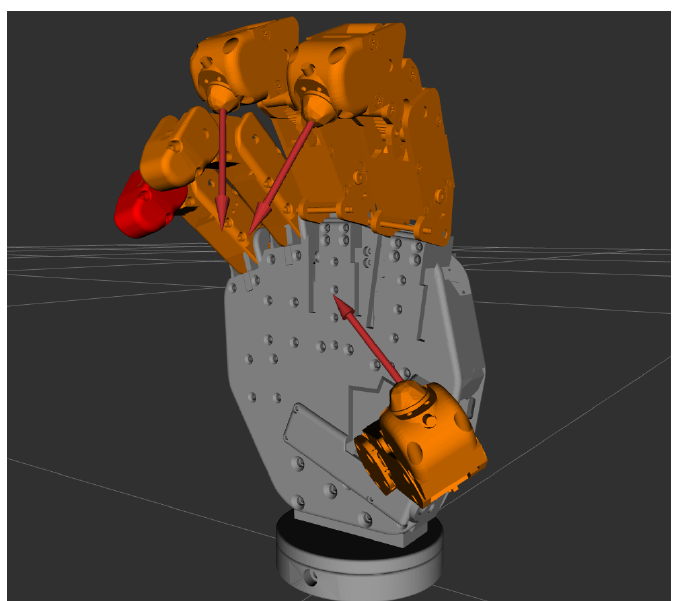
Figure 17. RViz visualisation of measured contact forces; red arrow represents the force, with arrow length corresponding to its